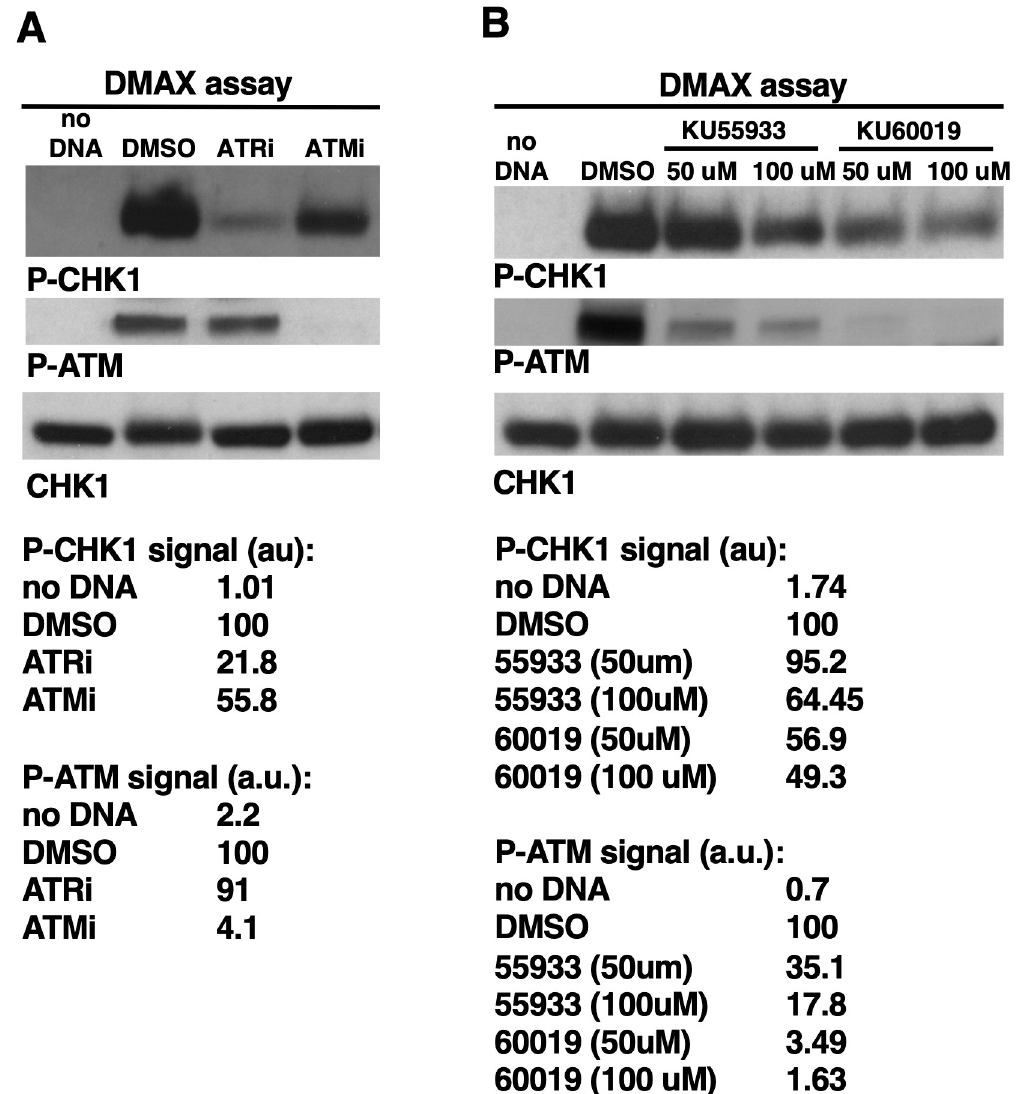
Fig 5. ATM kinase activity is not essential for ATR signaling in the DMAX system. A. XEEs were treated with the indicated compounds and then λ DSBs were optionally added. After incubation samples were taken and probed for the indicated proteins. The P-CHK1 and P-ATM signals were then quantified, as in Fig 3C. ATRi was present at 100 uM, as was ATMi (KU55933). The experiment shown is representative of two independently performed biological replicates. B. Same as (A) except ATRi was omitted and two different ATMis were used, at the indicated concentrations. The experiment shown is representative of two independently performed biological replicates.